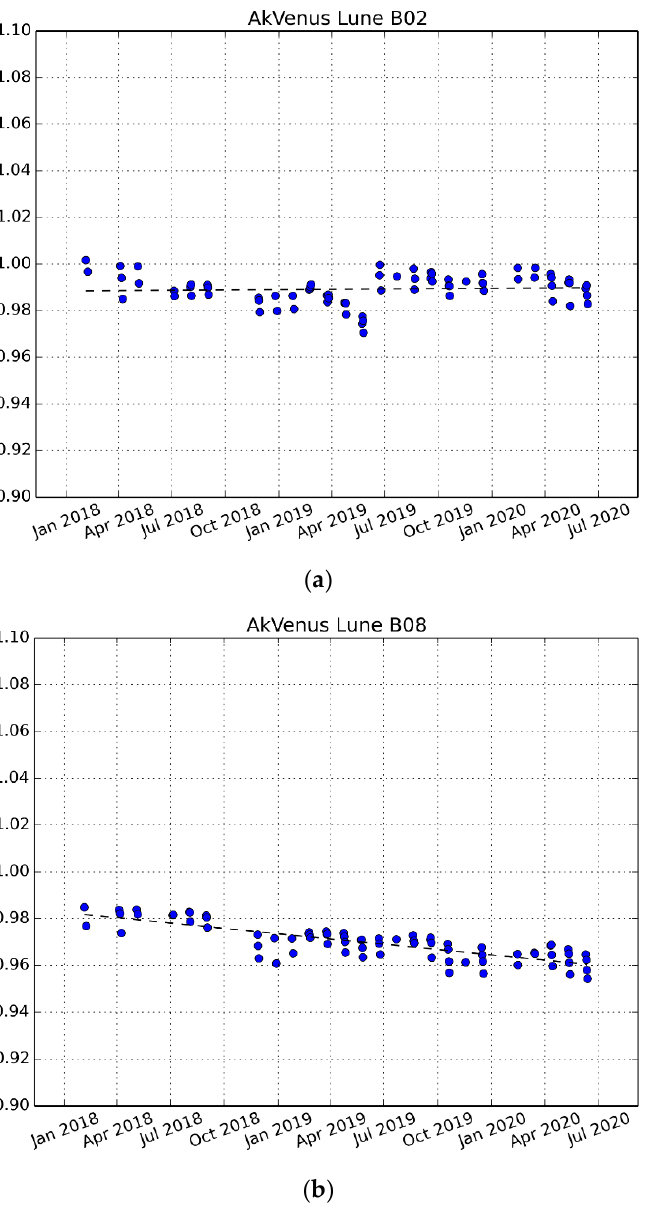
Figure 9. ( a ) Temporal variation of the absolute calibration coefficient for the spectral band B2 relative to the value at the beginning of the mission; ( b ) the same for the spectral band B8.